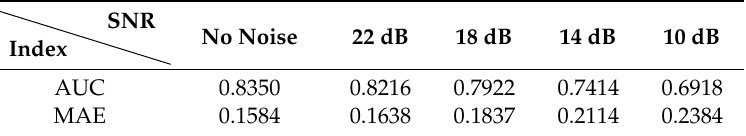
Table 1. Experimental results with different